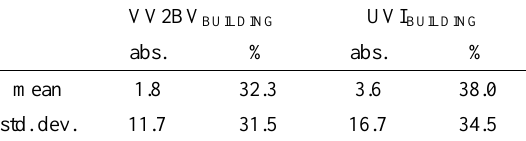
Table 2. Mean and standard deviation values for VV2BV and UVI indices in ‘building’ variant. Buffer distance equal to